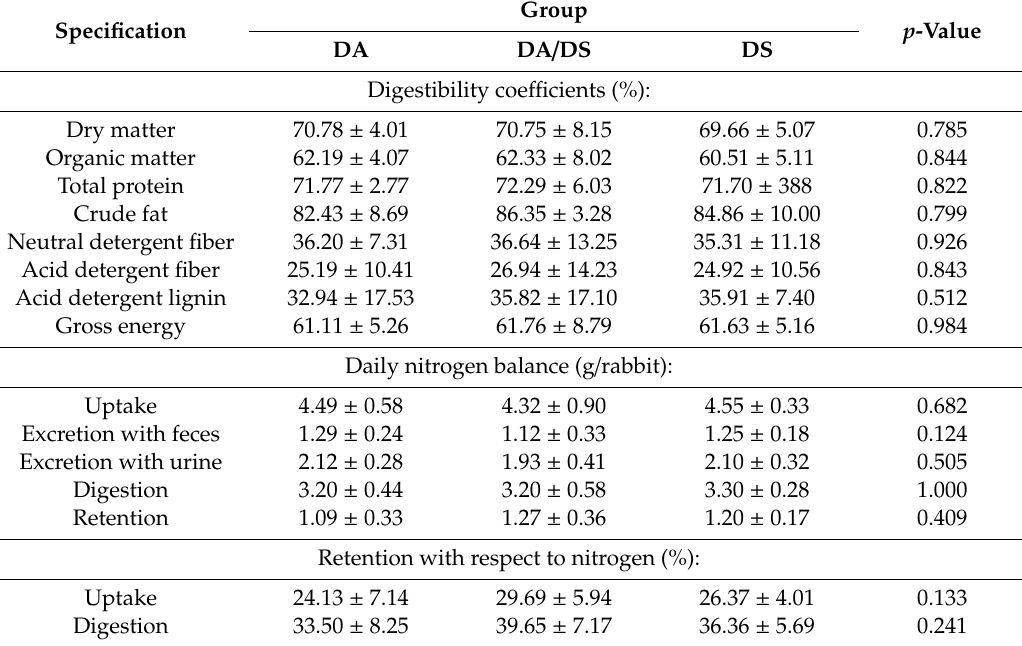
Table 5. Nutrient digestibility and nitrogen utilization in rabbits (mean ± SD; n =